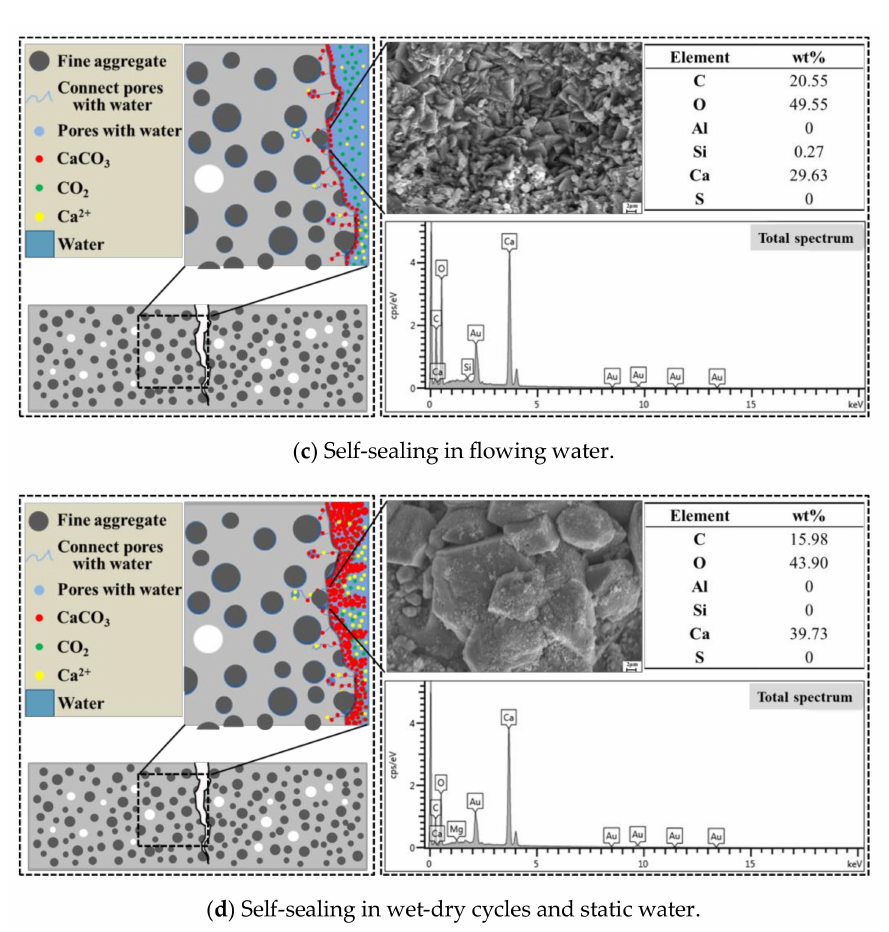
Figure 17. Mechanisms of self-sealing for samples cured in different